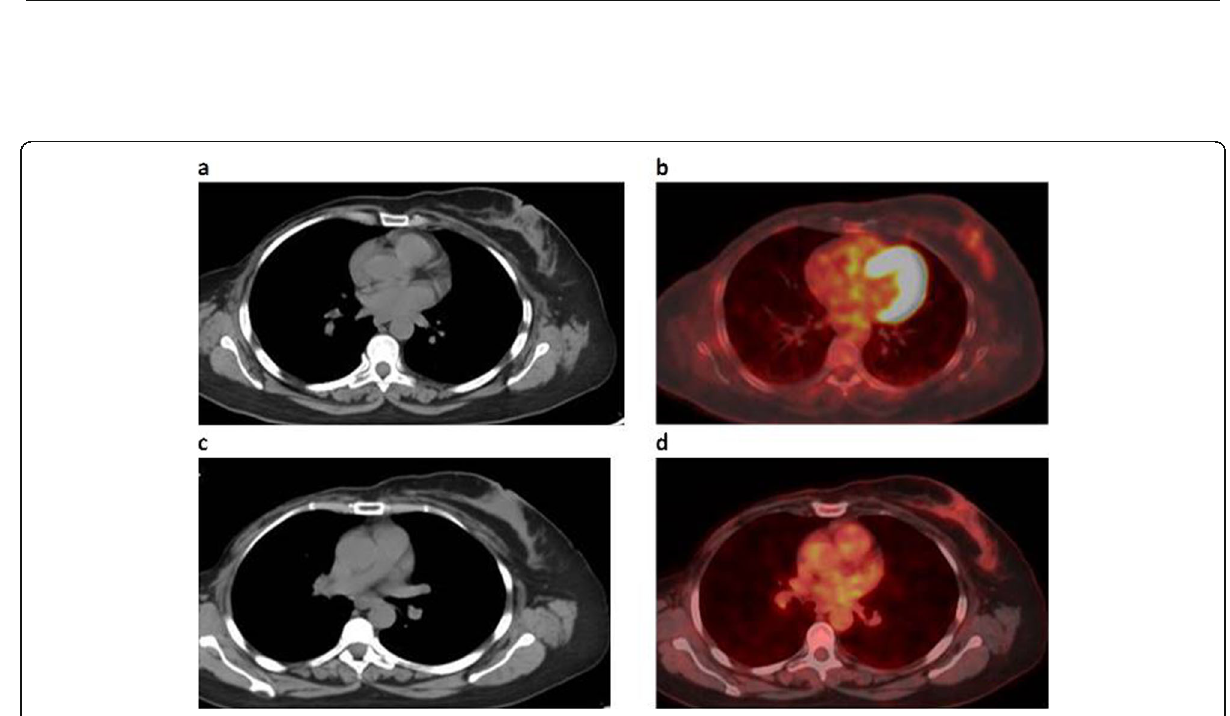
Fig. 5 56 years old female patient with history of right breast cancer submitted for MRM followed by chemotherapy presented with left breast cancer (invasive ductal carcinoma, luminal B subtype). Axial CECT and fused PET/CT images ( a, b ) revealed metabolically active left breast soft tissue mass lesion achieving 3 SUL peak . On follow-up after completion of chemotherapy, stationary appearance of the left breast mass regarding size and FDG uptake is noted in both axial CECT and fused PET/CT images ( c , d ) denoting stationary disease and stationary metabolic